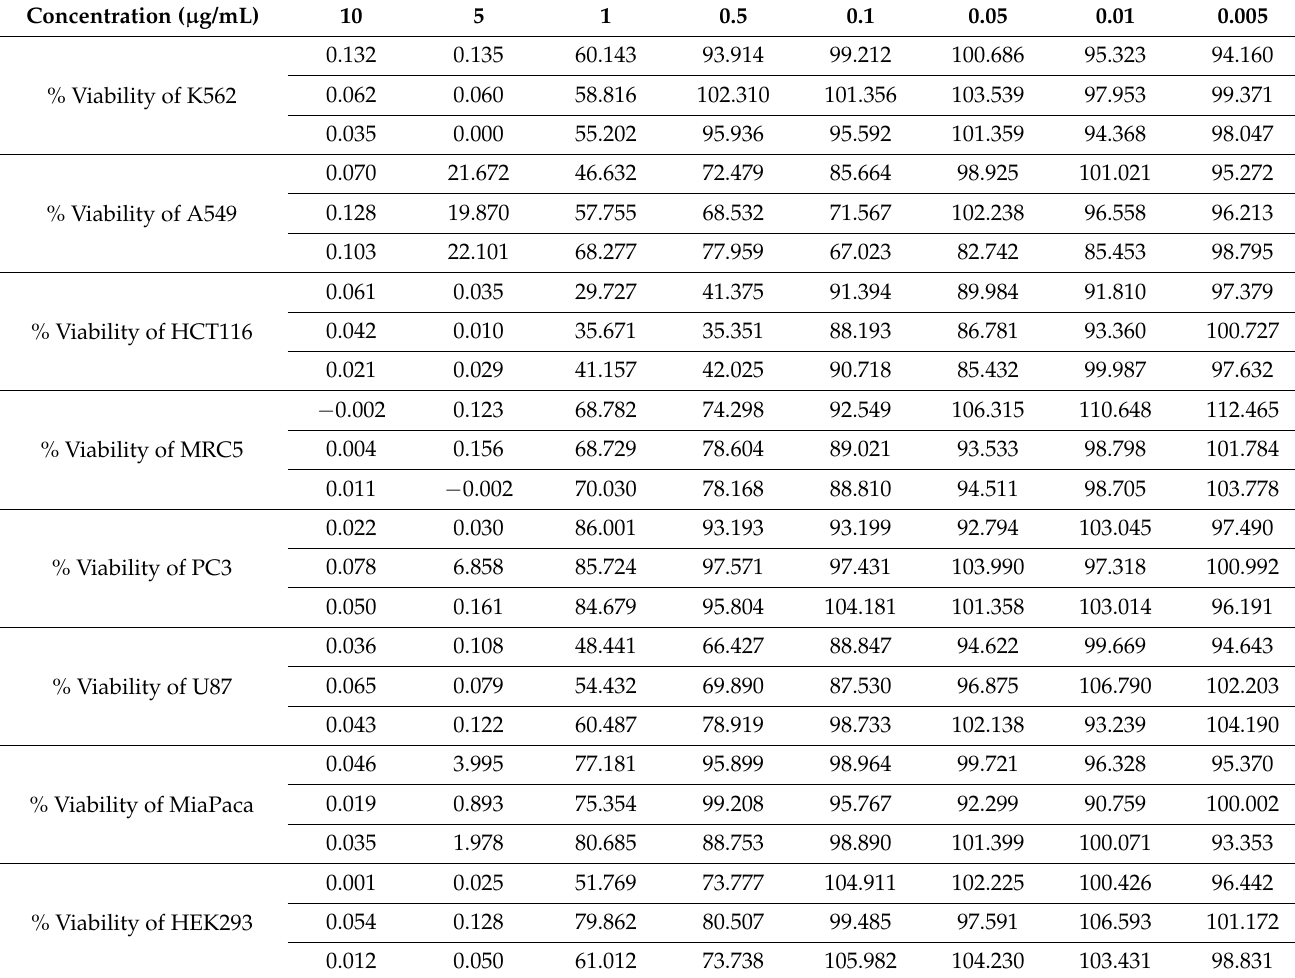
Table 5. Results of cytotoxicity activity of essential oils of Tagetes minuta